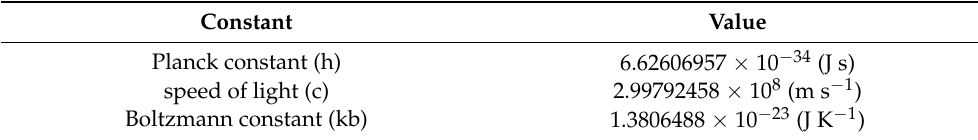
Table 3. Constants in BESP.m and NMT.m.